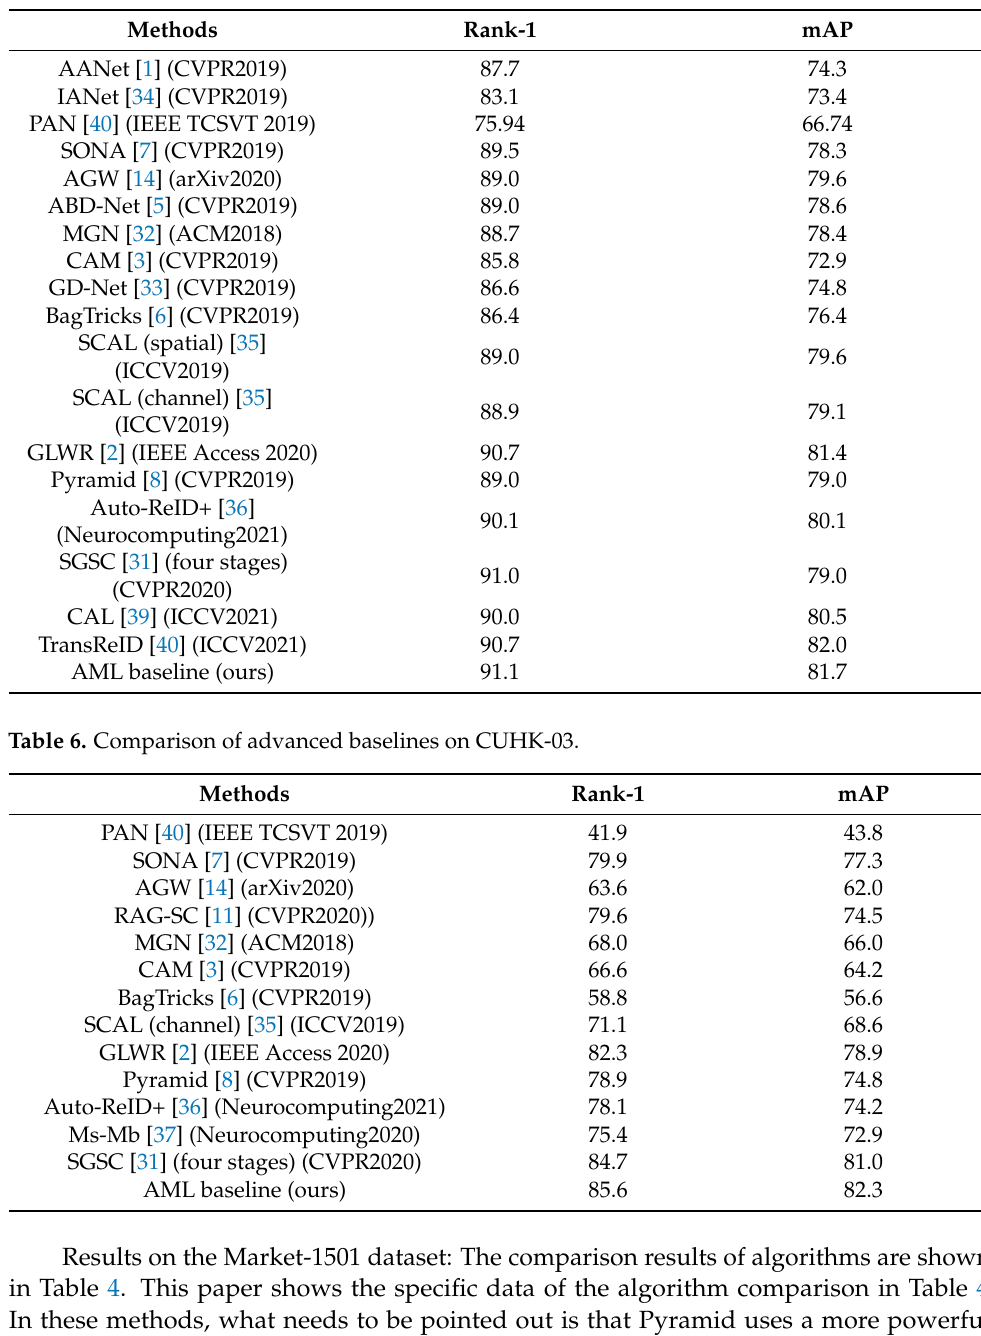
Table 5. Comparison of advanced baselines on DukeMTMC-ReID.